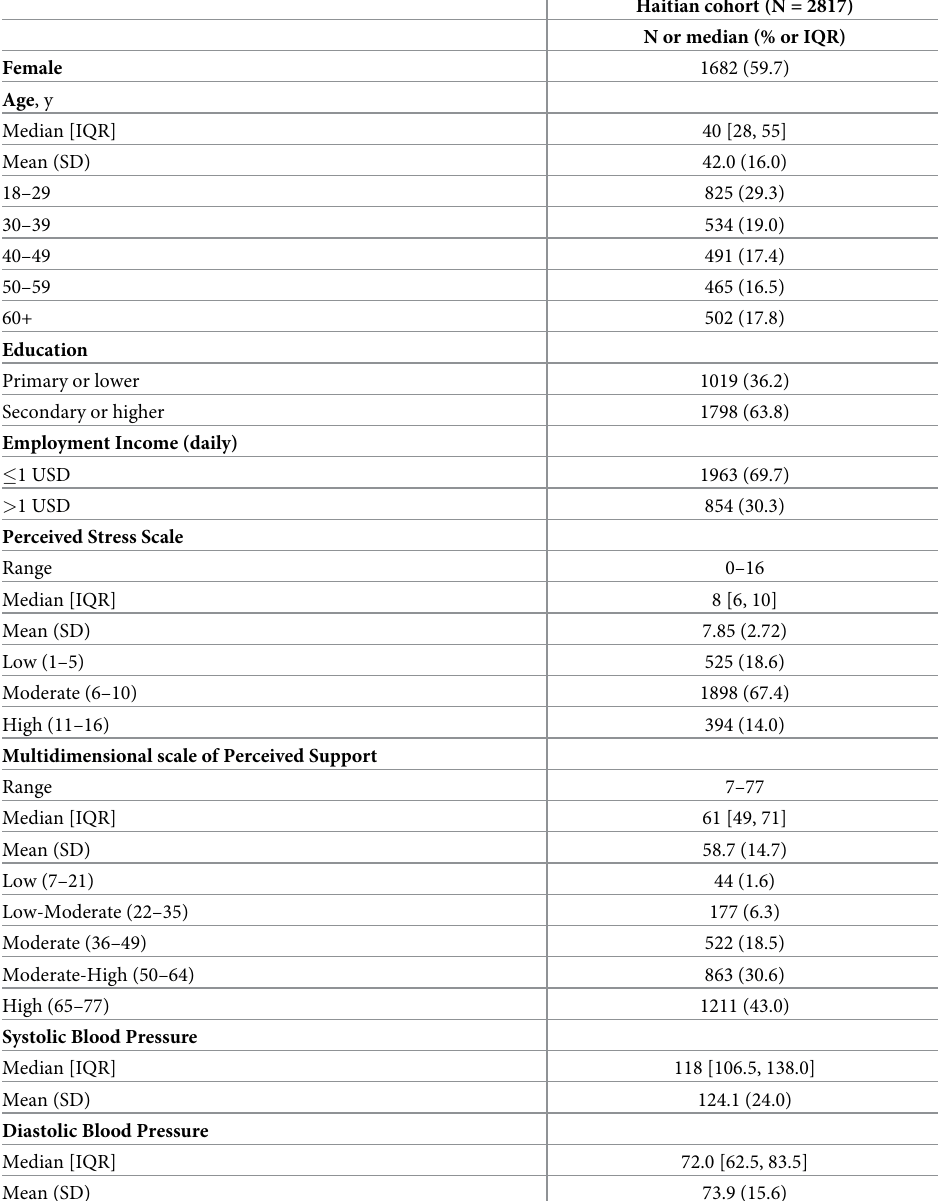
Table 1. Characteristics of Haiti CVD cohort